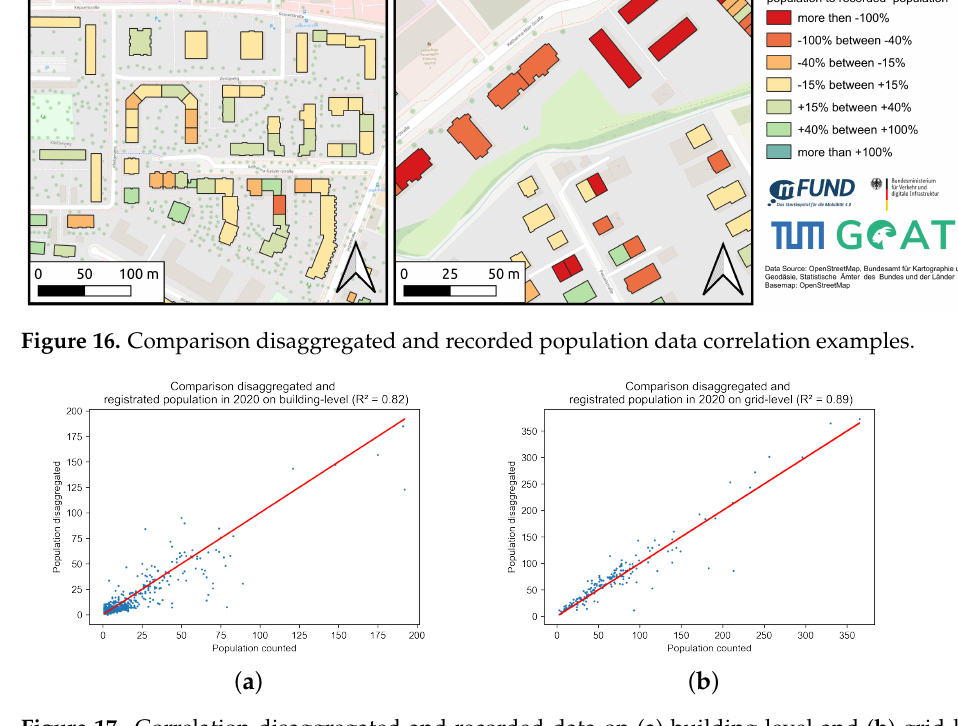
Figure 17. Correlation disaggregated and recorded data on ( a ) building-level and ( b ) grid-level (100 m × 100